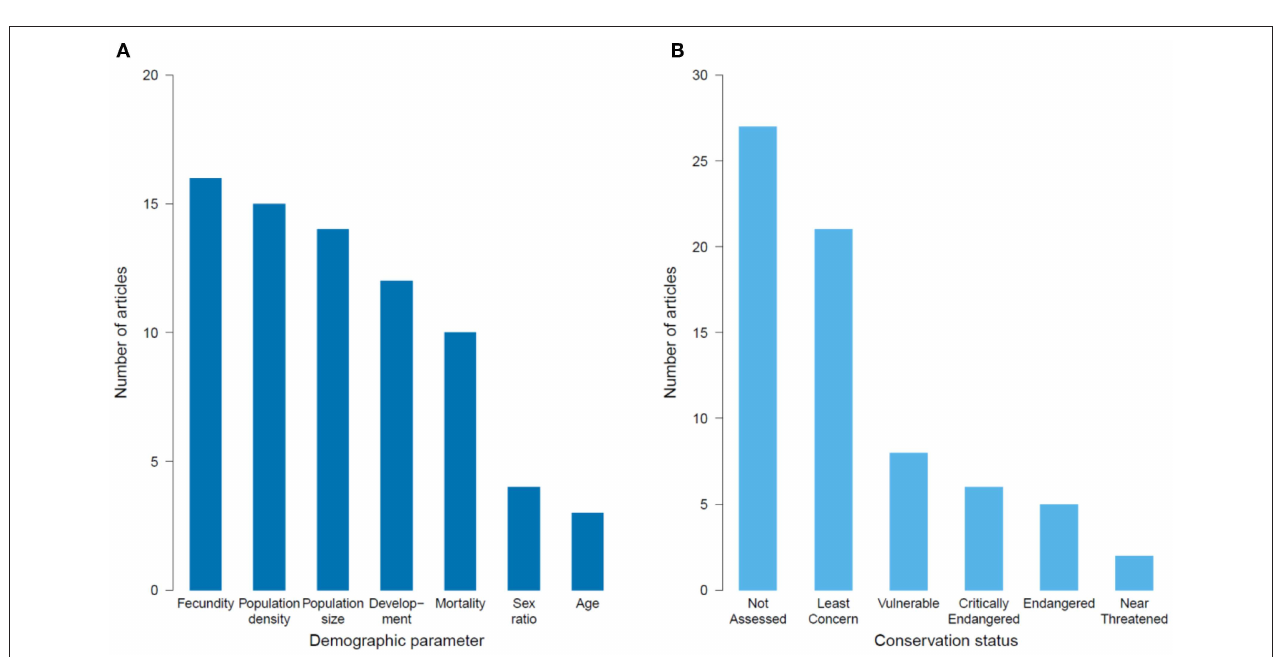
FIGURE 6 | Number of population ecology articles published on the impacts of habitat degradation on tropical montane biodiversity that: (A) measured different demographic parameters, and (B) studied species listed in the various categories of the IUCN Red List.